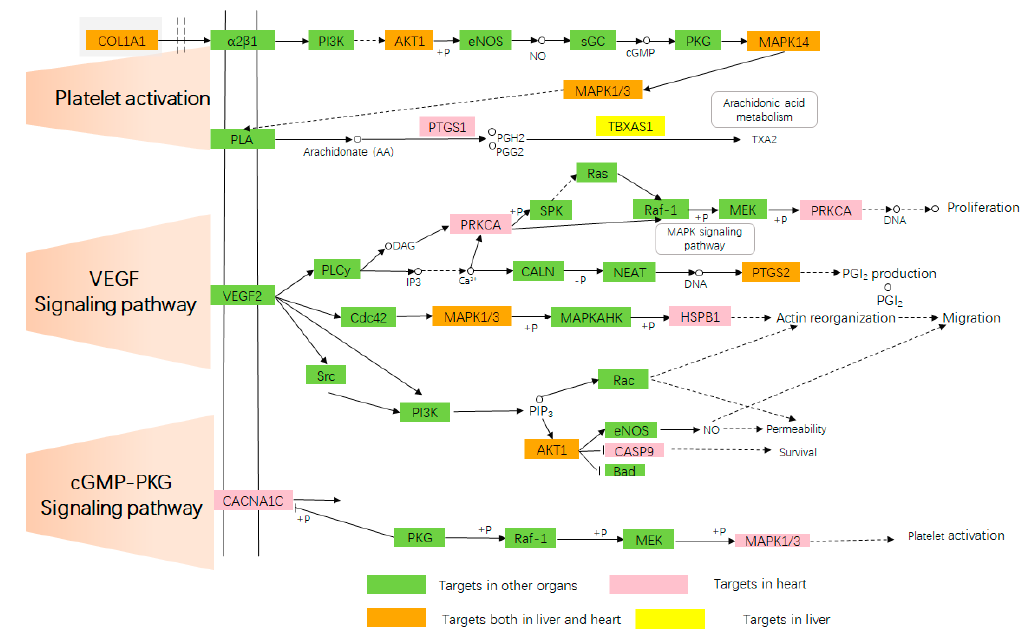
Figure 6. The representative cardiovascular disease pathway. The solid arrow represents molecular interaction or relation (activation), the dashed arrows indirect link or unknown reaction. The circle represents chemical compound, DNA and other moleculee. :molecular interaction or relation (inhibition).